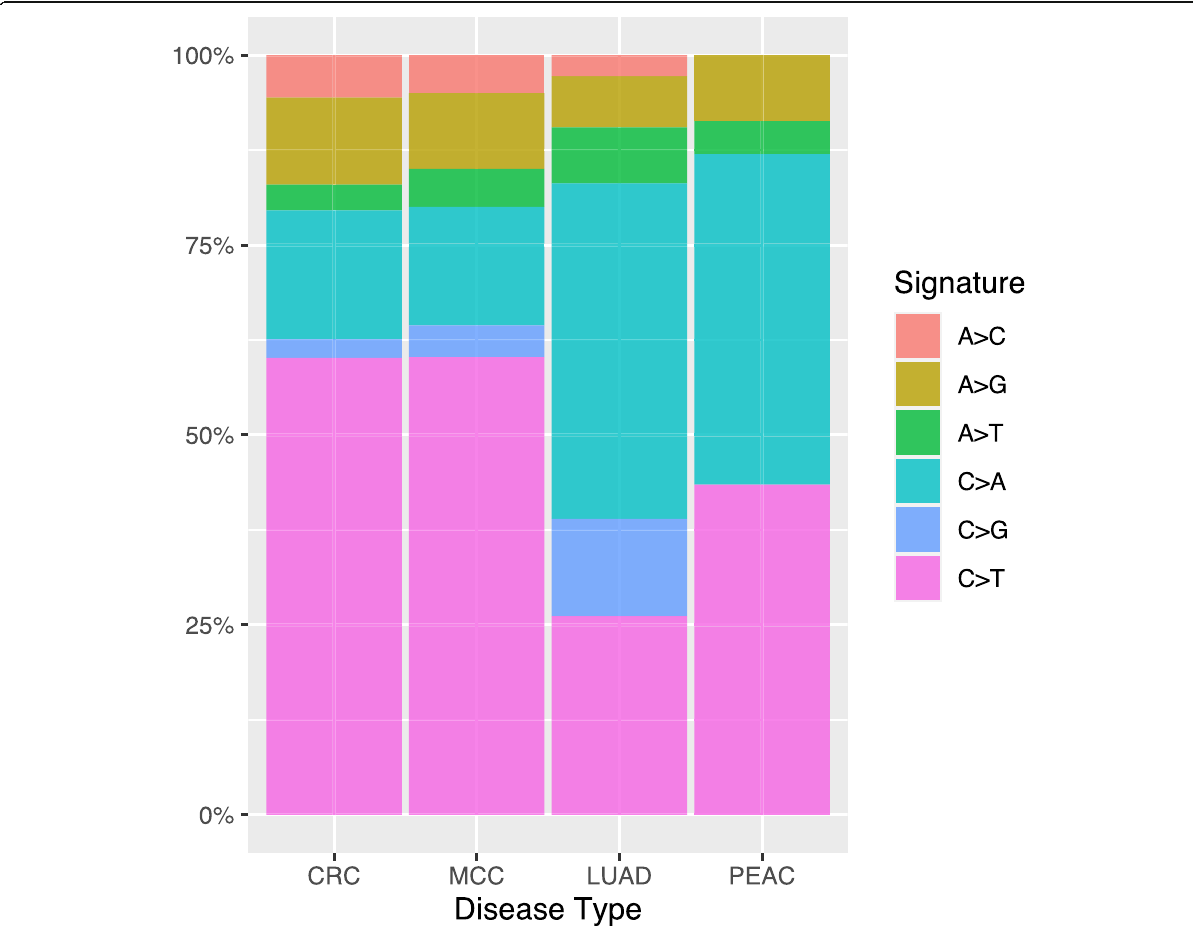
Fig. 4 Single nucleotide variant analysis in the PEAC cohort and comparison with TCGA and the MSKCC databases. CRC, colorectal cancer; LUAD, lung adenocarcinoma; MCC, metastatic colorectal carcinoma; PEAC, pulmonary enteric